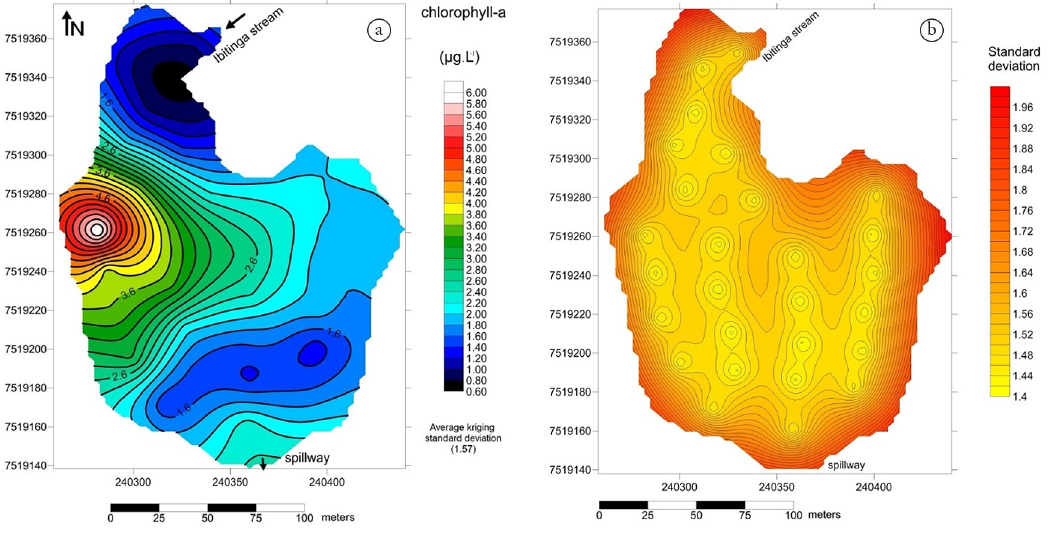
Figure 5. Estimates (a) and standard deviations (b) of the chlorophyll- a